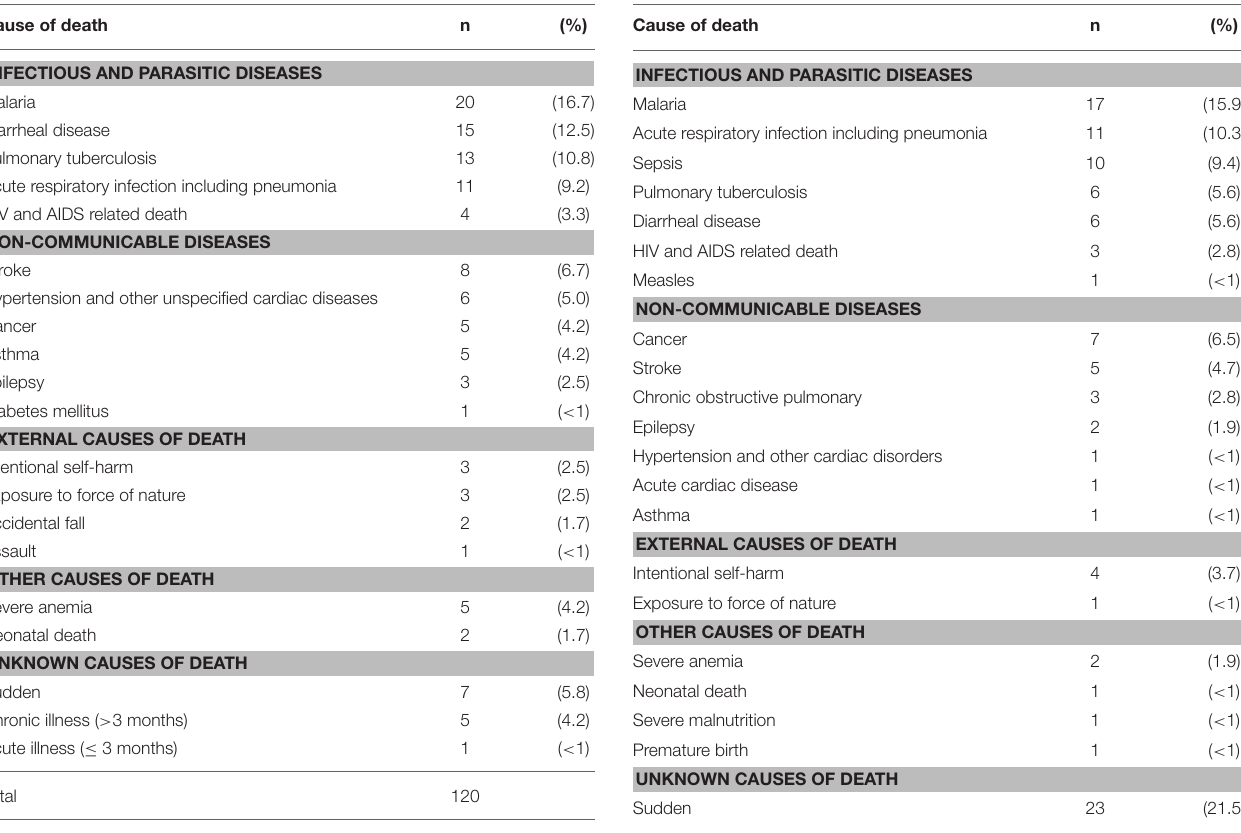
TABLE 2 | Causes of death documented by village headmen using simple verbal autopsy tool in 17 villages, traditional Authority, Mtema, Malawi: April 2016–September 2017.